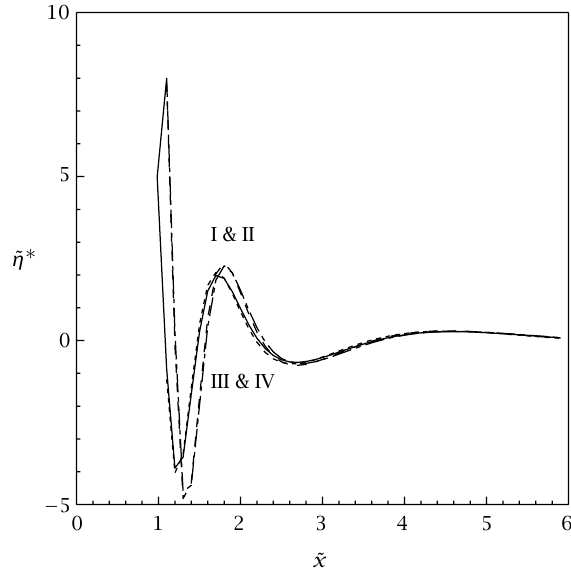
Figure 5.3 . Wave profiles due to an initial disturbance in the form of an impulse ( ˜ t = 8 . 0 ) , (cid:5)/h = 0 . 01, N 2 h/g = 0 . 1 I; (cid:5)/h = 0 . 01, N 2 h/g = 0 . 0 II; (cid:5)/h = 0 . 0, N 2 h/g = 0 . 1 III; (cid:5)/h = 0 . 0, N 2 h/g = 0 . 0 IV.